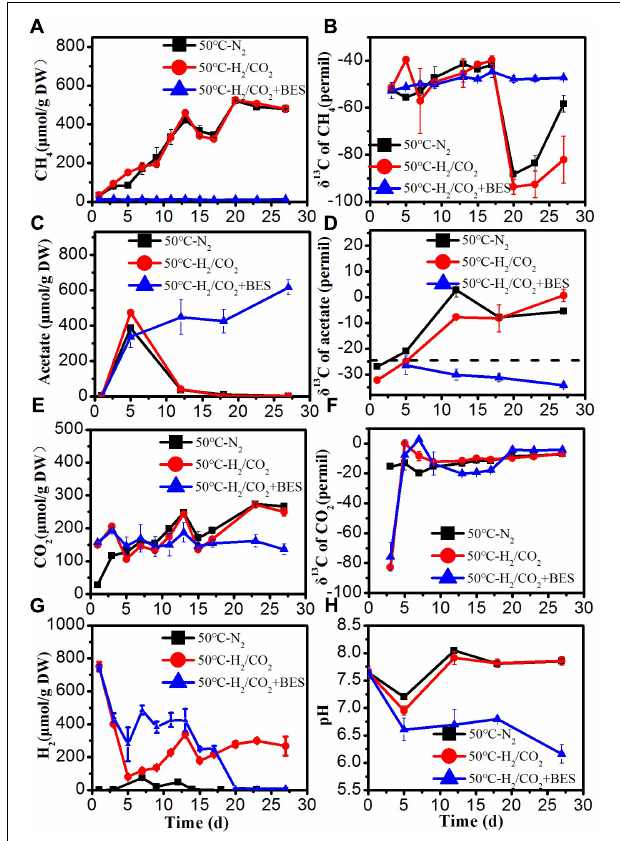
FIGURE 3 | Time course of accumulated (A) CH 4 , (B) δ 13 C of CH 4 , (C) acetate, (D) δ 13 C of acetate, (E) CO 2 , (F) δ 13 C of CO 2 , (G) H 2 concentration, and (H) pH during the treatment of sewage sludge at 50 ◦ C, BES as an inhibiter of methanogenesis. The δ 13 C of the sludge organic